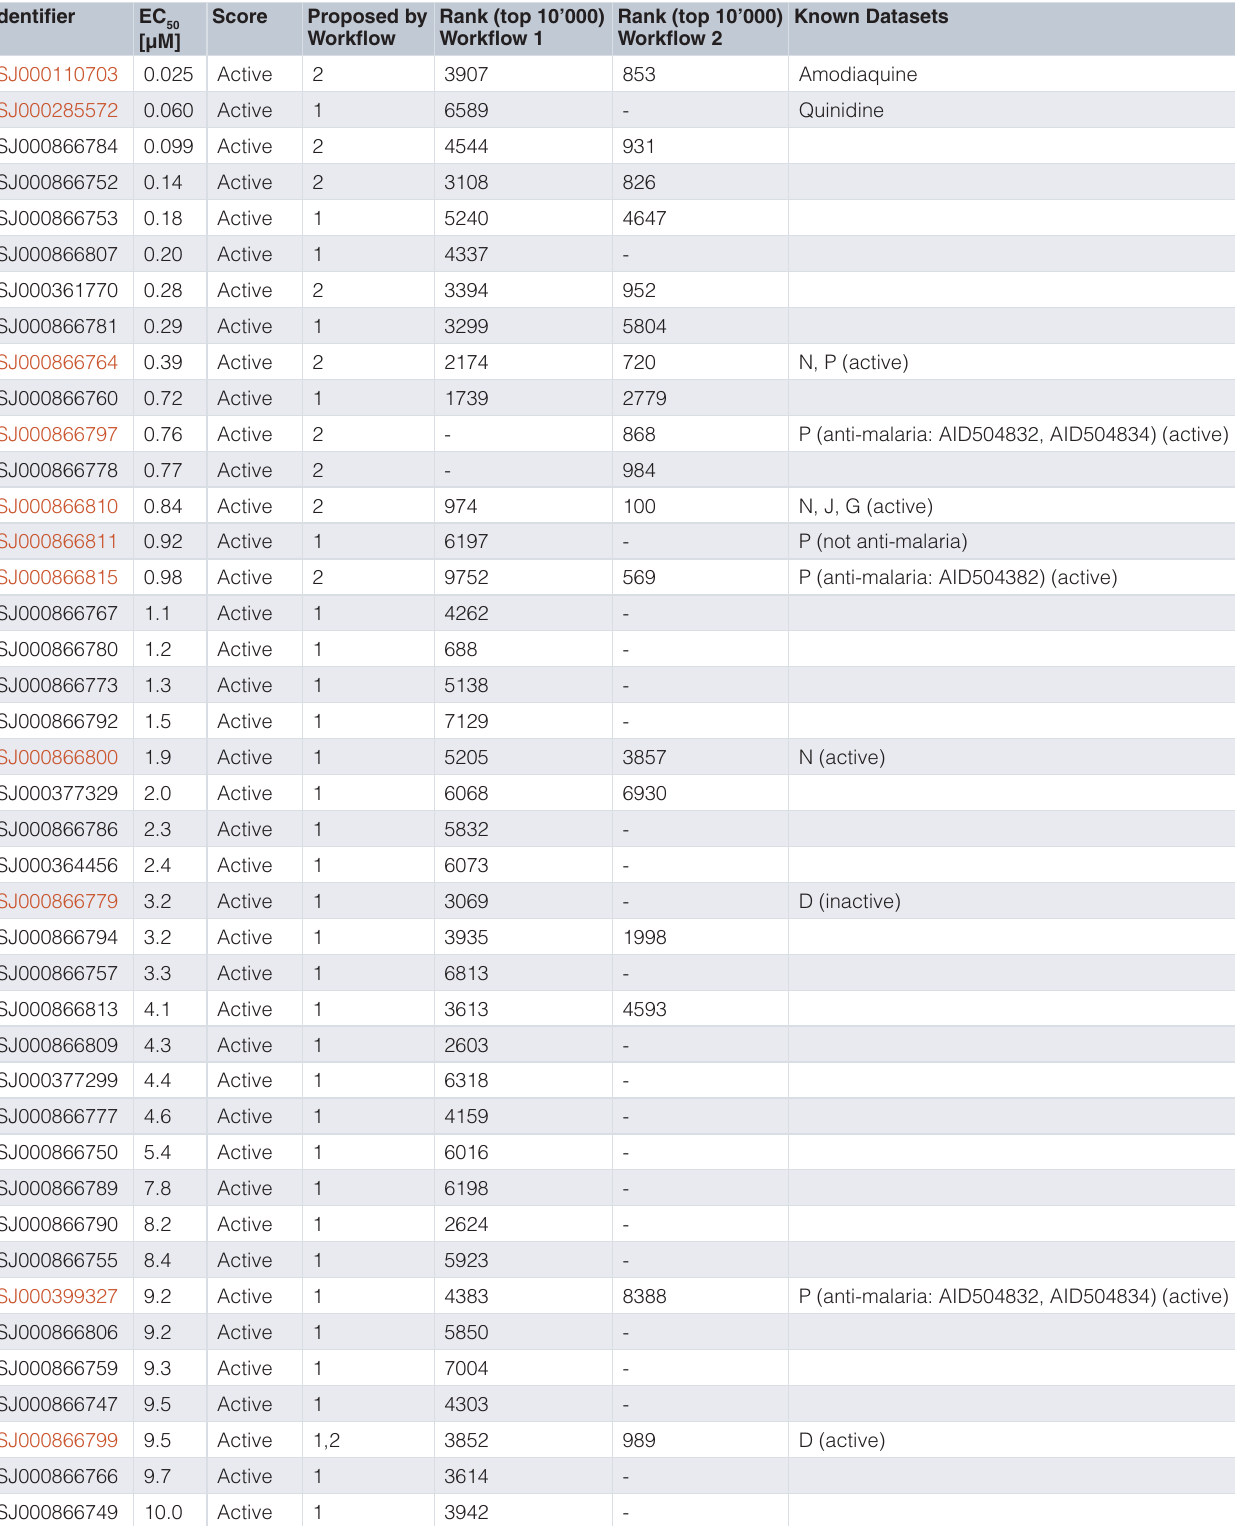
Table 5. Results from the follow-up assay for 83 compounds. The columns are as follows: EC inactive), and the ranks in the Workflows 1 and 2. Partially active or single-point active compounds were considered inactives (marked by italic font). ChEMBL-NTD datasets: Novartis-GNF Malaria Box (N) 40 , St. Jude Children’s Research Hospital Dataset (J) 24 , GSK TCAMS (G) 41 , DNDi HAT set (D). Compounds marked with (P) were tested in PubChem